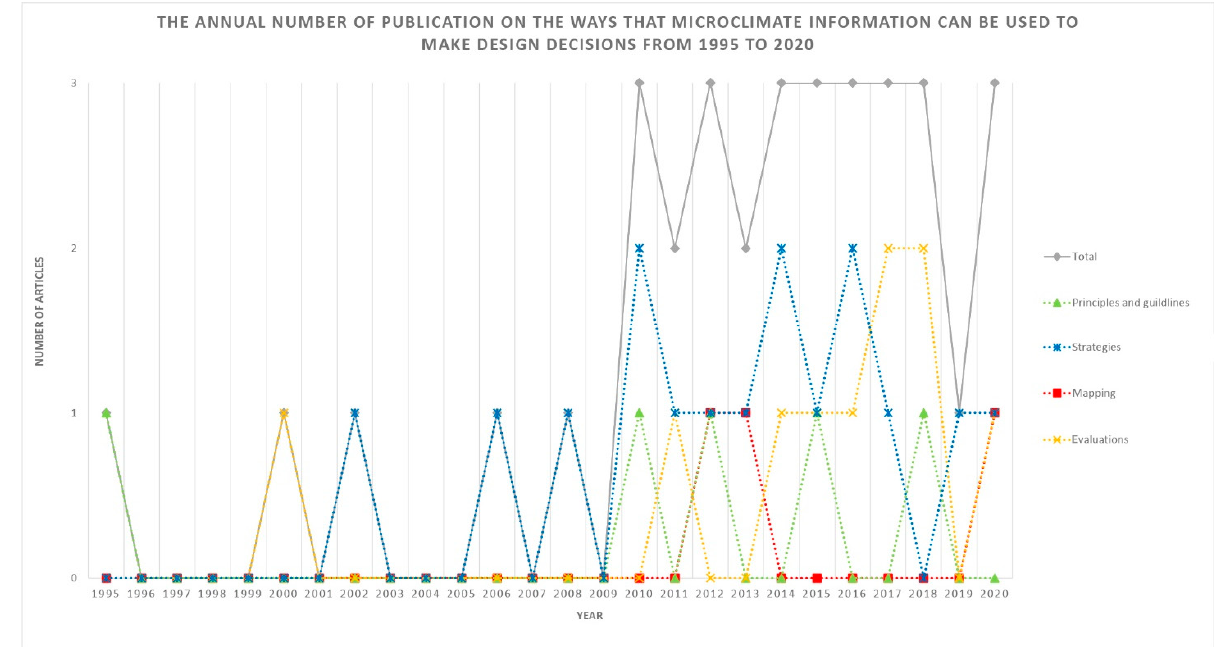
Figure 2. Annual number of publications on the way that applying microclimate to landscape architecture from 1995 to 2020.